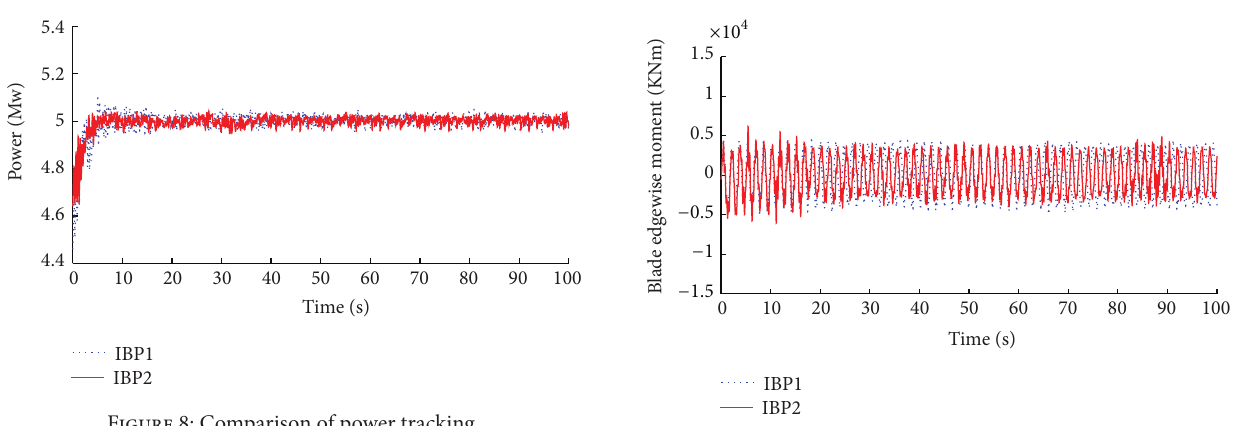
Figure 9: Comparison of blade edgewise